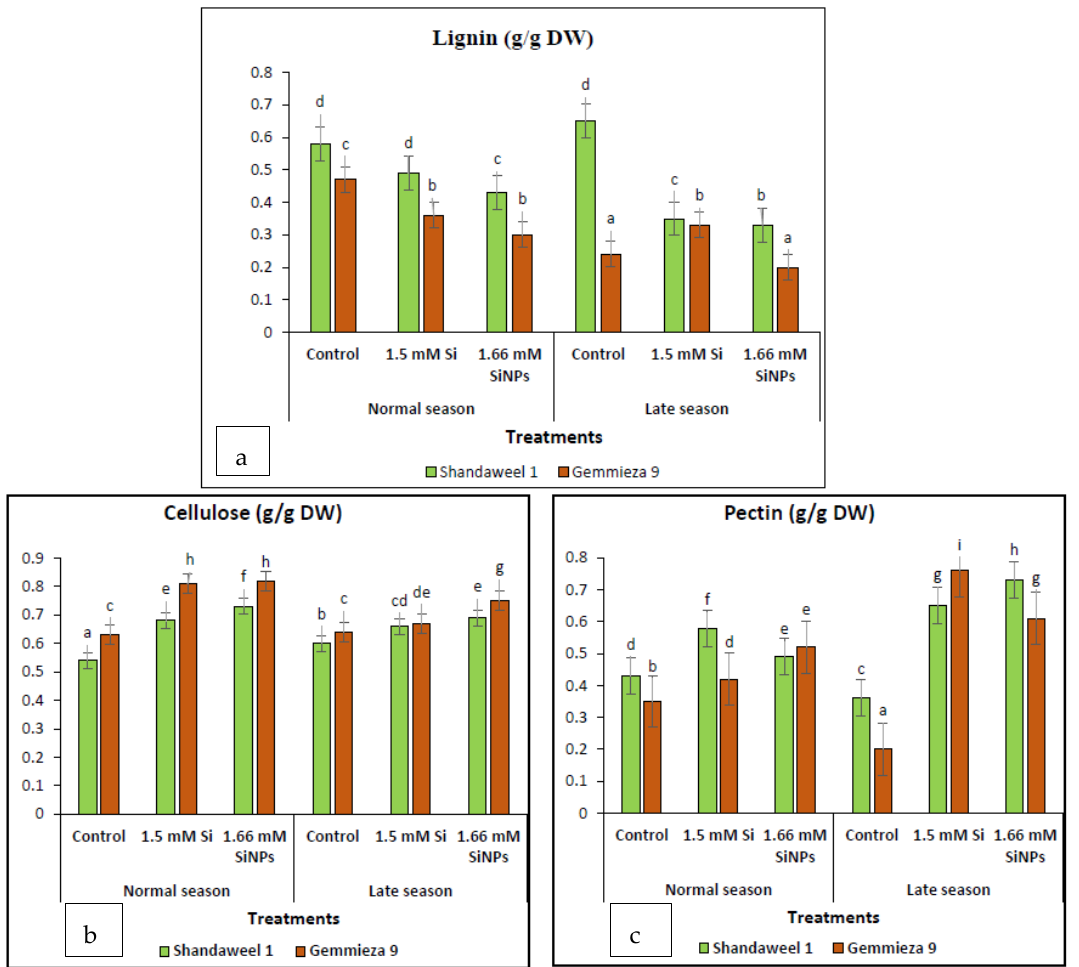
Figure 3. Effects of silicon and nanosilicon on ( a ) lignin, ( b ) cellulose and ( c ) pectin contents in straw of two wheat cultivars cv. Shandaweel 1 and cv. Gemmeiza 9 at normal and late seasons. Data expressed as (g/1g DW). Each value is the main of three different replicates ± SE. Columns with different letters are significantly different at p < 0.05. Table 9. Effects of silicon and nanosilicon on inorganic phosphorous, phytate P, phytic acid and